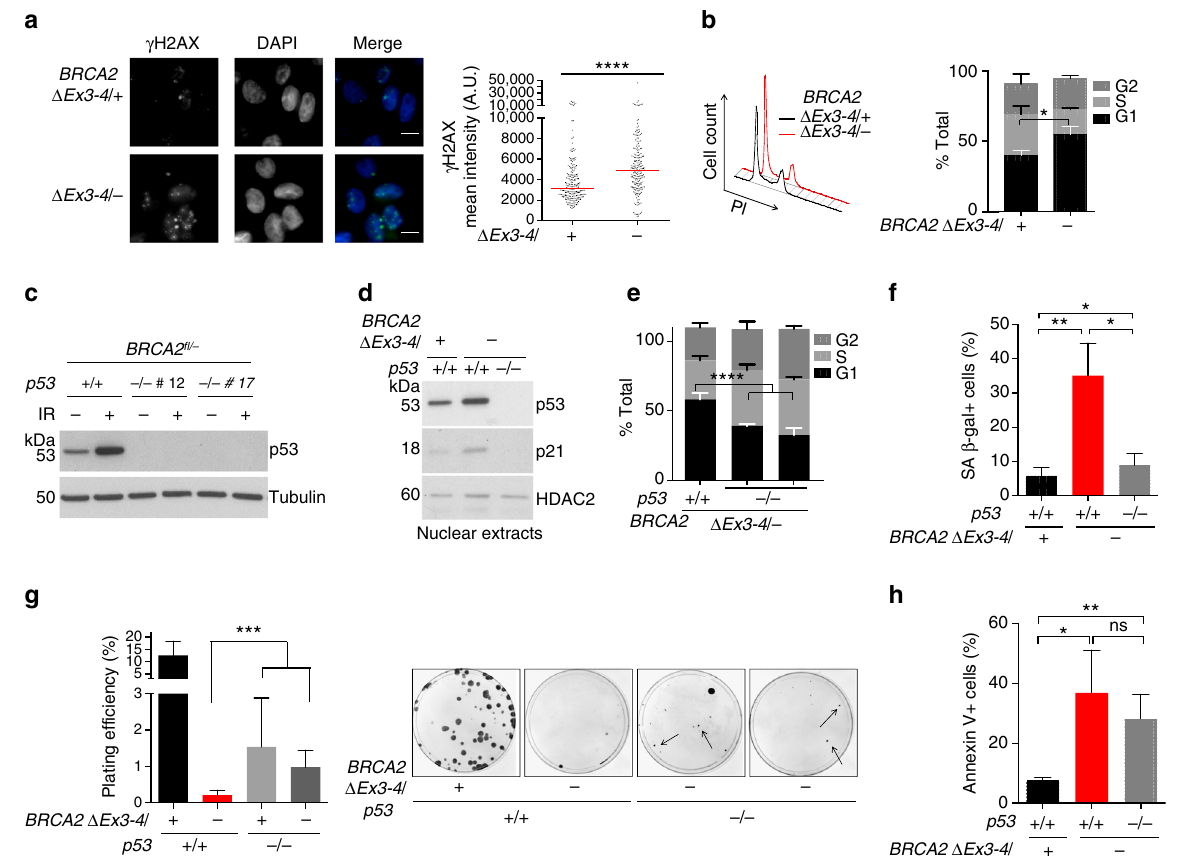
Fig. 3 BRCA2 de fi ciency triggers spontaneous DNA damage and G1 arrest. a BRCA2 Δ Ex3-4/ − cells were immunostained for γ H2AX. DNA was counterstained with DAPI. Representative images ( left ) and quanti fi cation of γ H2AX mean nuclear intensity ( right ) are shown with analysis by a two-tailed Mann – Whitney test. Median γ H2AX intensity, red bars . Scale bars 10 µ m. b Cell cycle analysis demonstrates an increase in the G1 fraction upon BRCA2 de fi ciency. Representative plots displaying results from the same amount of cells for both samples are shown on the left . An unpaired two-tailed t -test was used for the analysis. n ≥ 3. c Western blot showing p53 loss. Cells were harvested 2 h after 10 Gy irradiation (IR). Two independent BRCA2 fl / − p53 − / − clones were analyzed. d Western blots of nuclear extracts prepared from the indicated cells. e Cell cycle analysis. An unpaired two-tailed t -test was used for the analysis. n ≥ 3. f Cellular senescence, as indicated by SA β -gal staining. An unpaired two-tailed t -test was used for the analysis. n ≥ 3. g p53 loss leads to a partial increase in clonogenic survival of BRCA2-de fi cient cells. Left : plating ef fi ciency, as analyzed by an unpaired two-tailed t -test. n ≥ 3. Right : images of representative plates. Arrows highlight typical PCR-validated BRCA2 Δ Ex3-4/ − p53 − / − colonies. h Apoptosis analysis using Annexin V